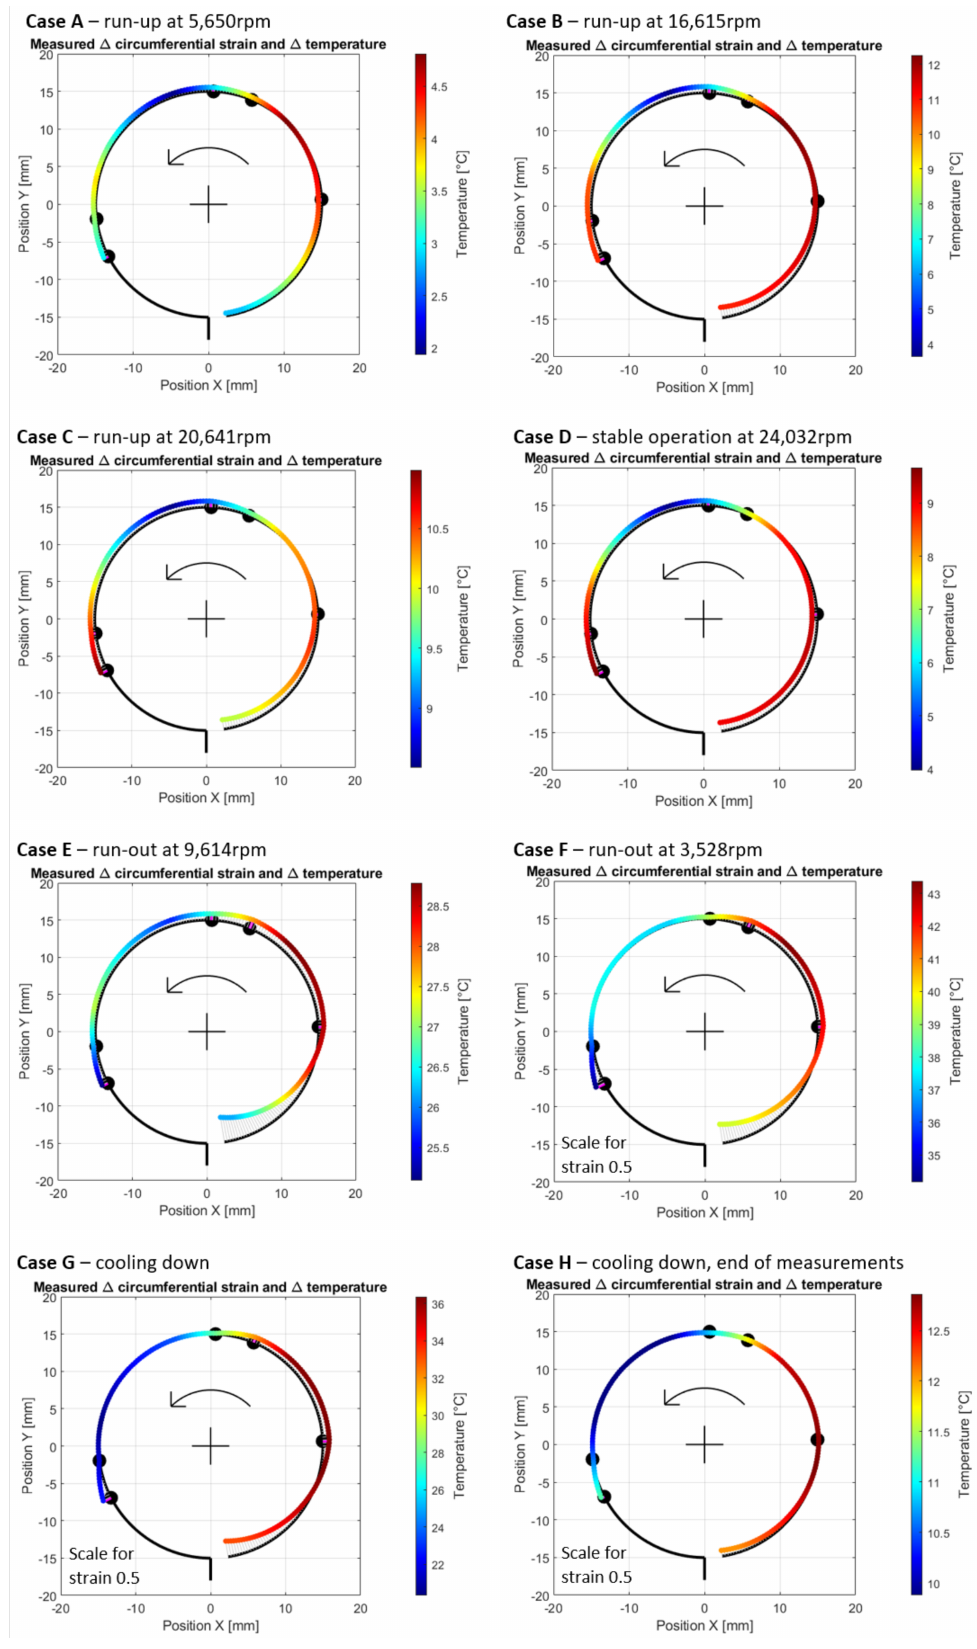
Figure 19. Compacted cross-sectional views for the circumferential distribution of the temperature and strain identified in the top foil for the studied cases ( A – H ), referencing the various stages of the GFB’s